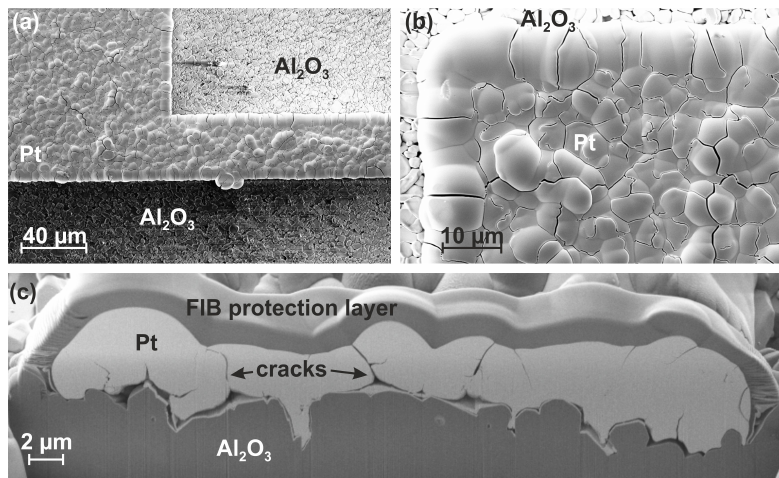
Figure 5. SEM micrographs (10 kV, SE2) of an electroless-deposited Pt-based antenna structure on an Al 2 O 3 ( R a = 0.6 µ m) substrate, ( a , b ) top-view images, ( c ) SEM (3 kV, SE2) image of the cross